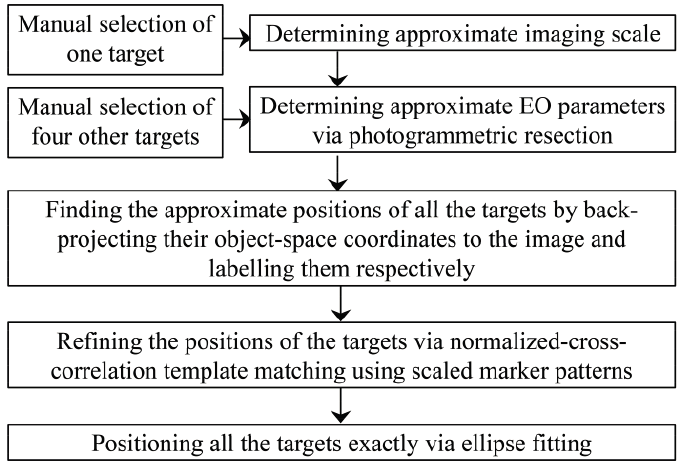
Figure 3. Diagram of the target detection